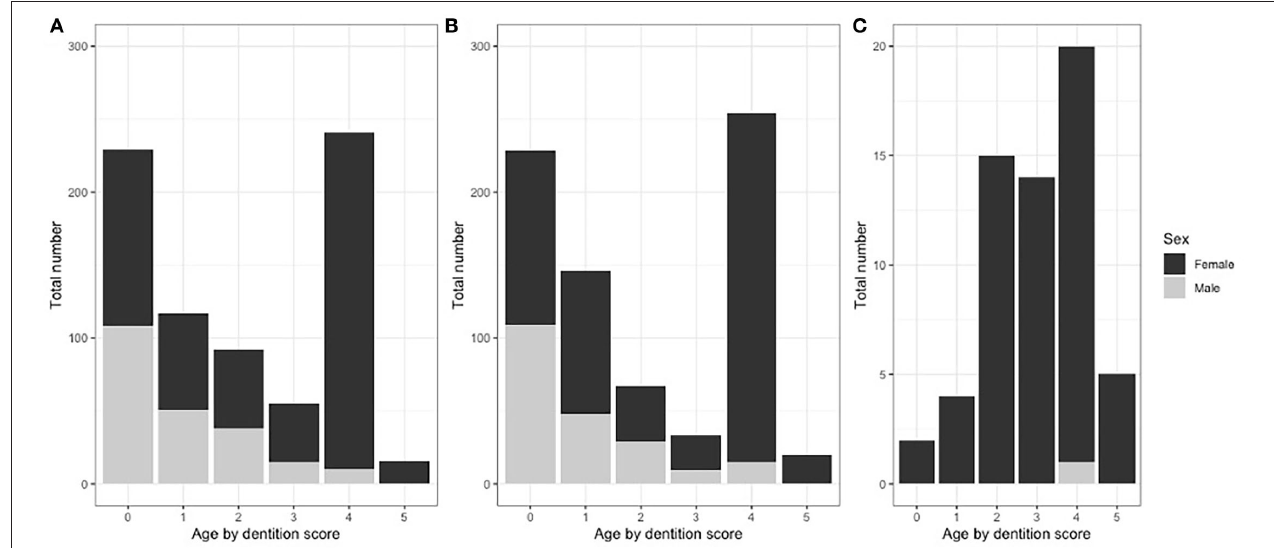
FIGURE 2 | Proportions of cattle sample by dentition score, sex and study site grouping. (A) NWR pastoral cattle ( n = 750), (B) VIN pastoral cattle ( n = 748), and (C) NWR dairy cattle ( n = 60).